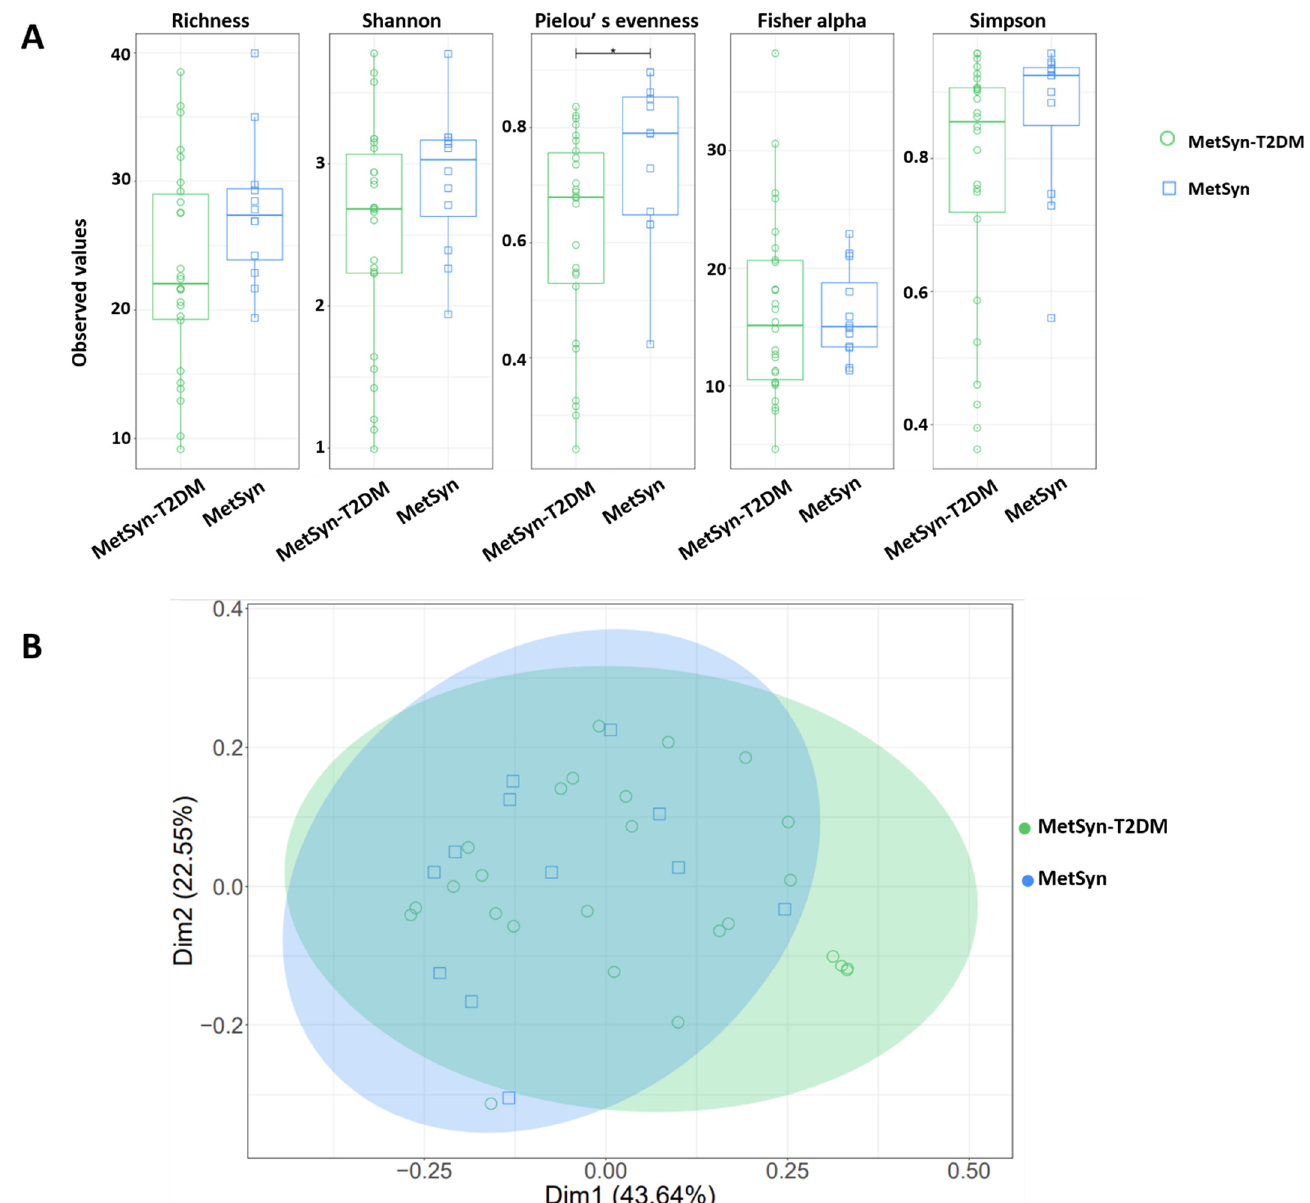
Figure 4. Microbial diversity and community structure for MetSyn and MetSyn-T2DM patients. ( A ) alpha diversity measurements; ( B ) Beta diversity analysis-weighed UniFrac